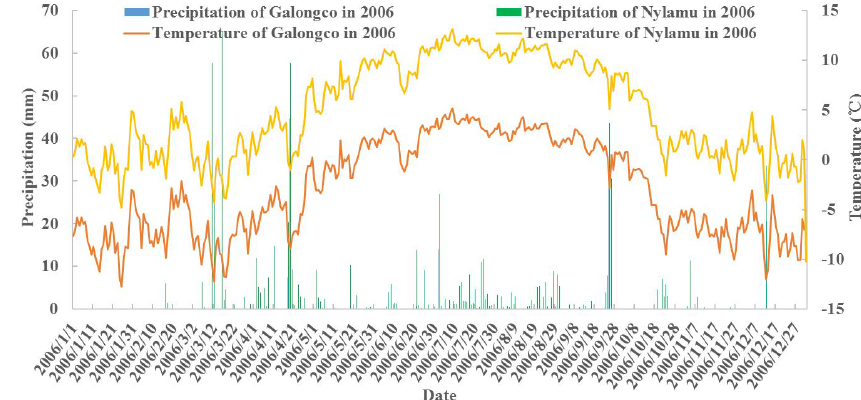
Figure 16. Temperature and precipitation of Galongco Lake in